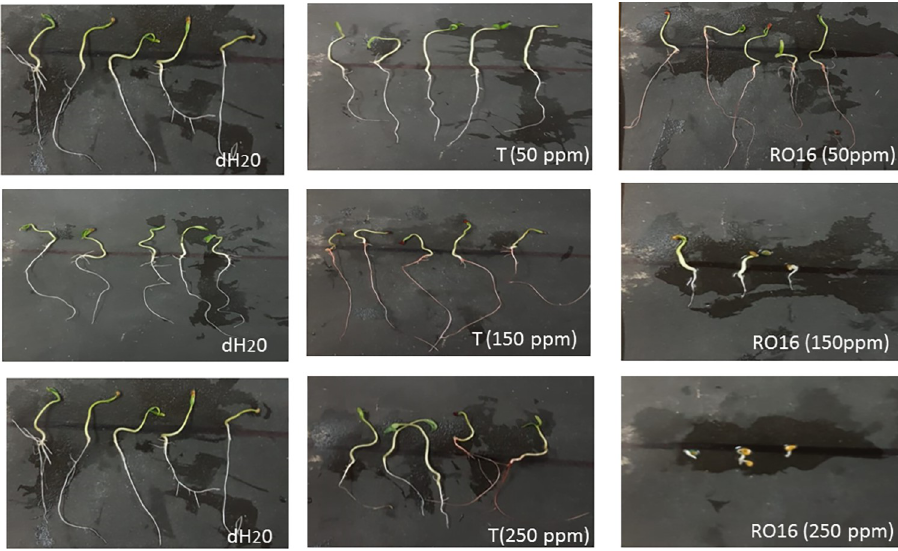
Fig 6. Comparison of phytotoxicity on growth parameter of plant Solanum lycopersicum (Riogrande ). While treating it with various concentrations of reactive orange 16, treated reactive orange 16 with ROC (T) and control (dH 2